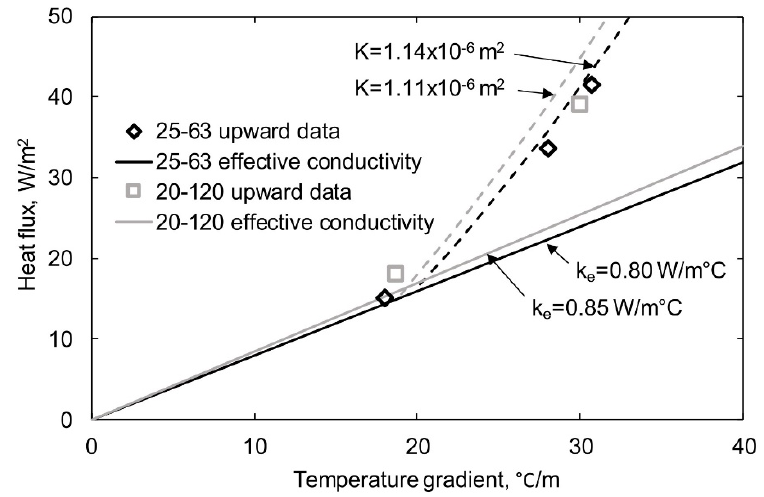
Figure 18. Experimental data for upward and downward heat flow through 25–63 and 20–120 mm materials as reported by NGI (1999) [21].